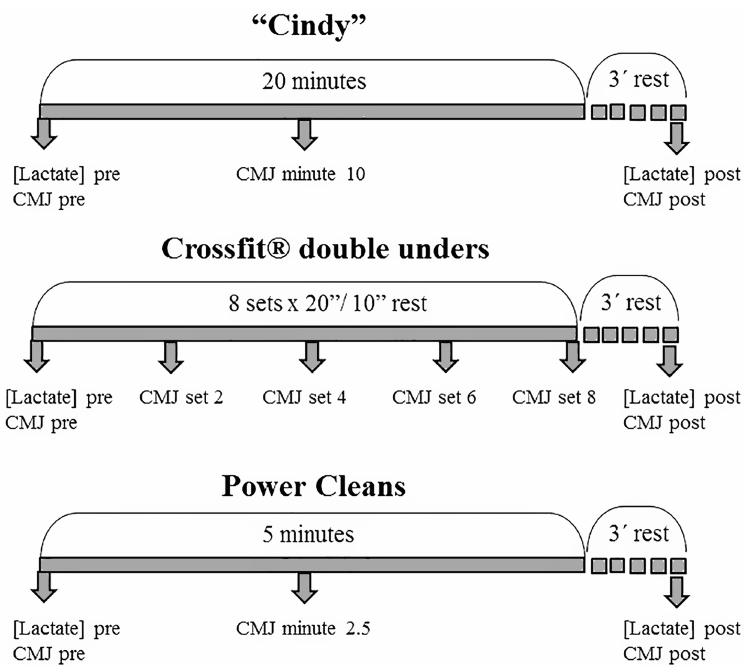
Fig 1. Three modalities of CrossFit WOD; Gymnastics (Cindy), Metabolic conditioning (Crossfit double-unders) and Weightlifting (Power Cleans). The figure shows the working times and [Lactate] and Countermovement Jump measurements in each Crossfit